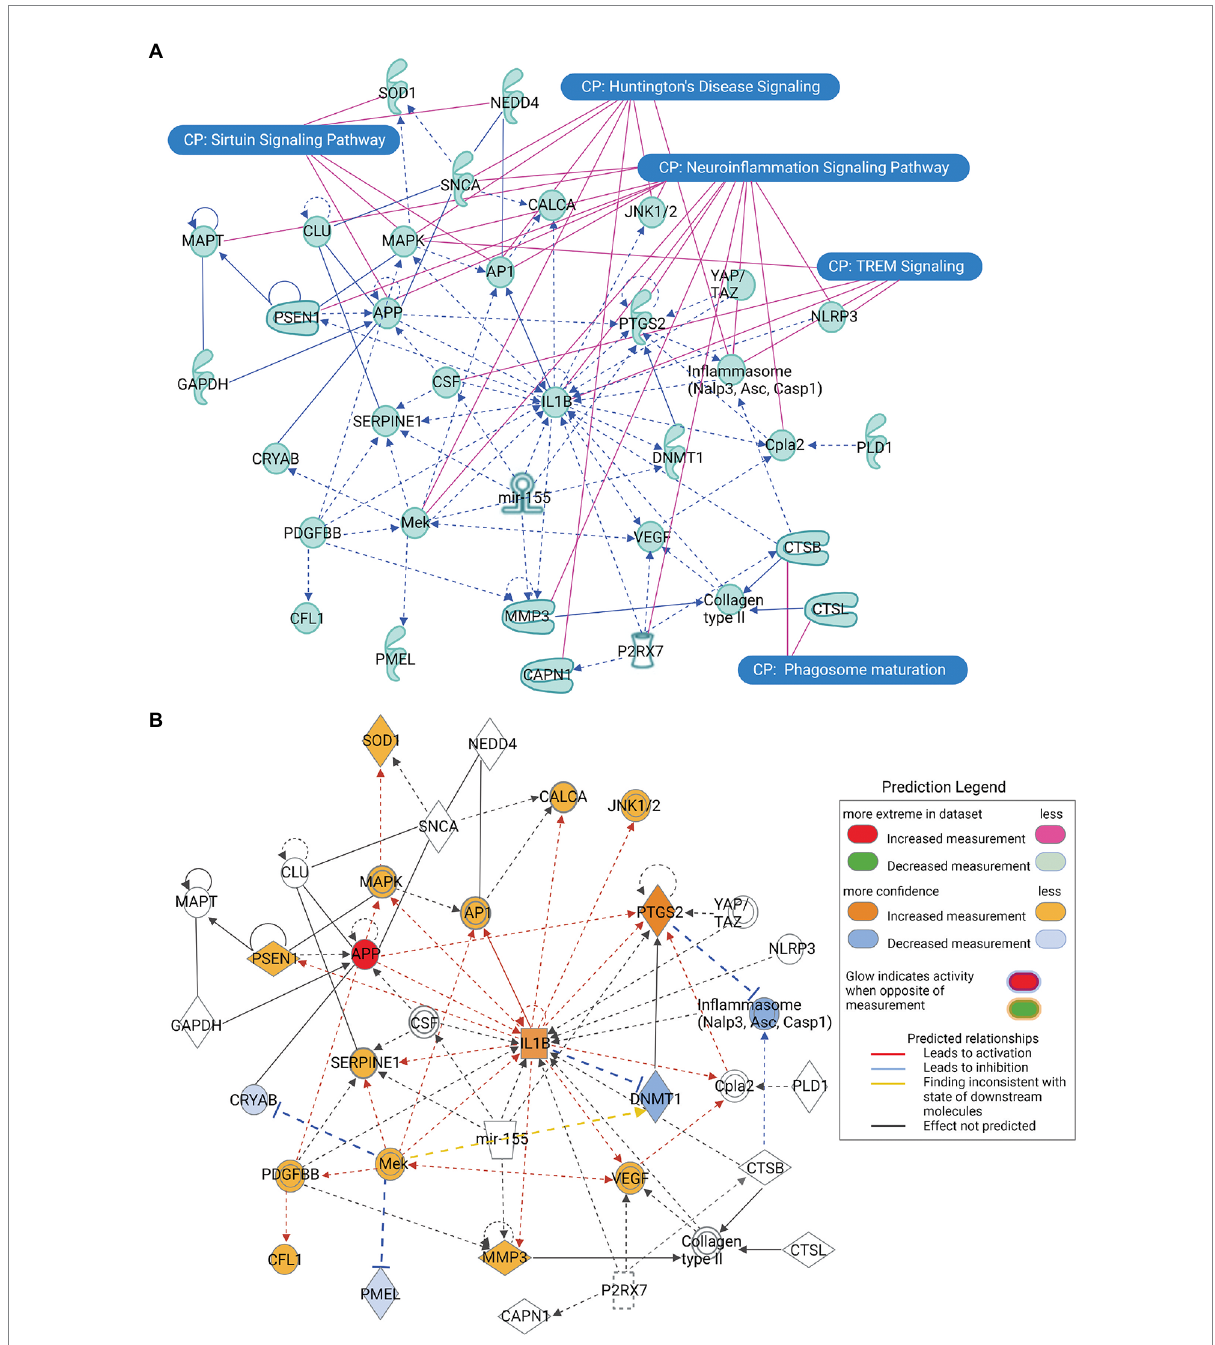
FIGURE 3 The principal interaction network of α -synuclein gene SNCA across all the predicted canonical signaling pathways. (A) The principal interaction network of SNCA revealed that SNCA directly interacts with APP, CLU, and NEDD4, whereas it interacts indirectly with CALCA and SOD1. Furthermore, the overlapping of the principal interaction network of α -synuclein and top-ranked canonical signaling pathways highlights a relationship between the interaction network genes and canonical pathways. (B) The molecule activity predictor (MAP) analysis of the principal interaction network of SNCA, depicting that increase in the activity of APP leads to a series of activation and inhibition of network genes. Figure created with